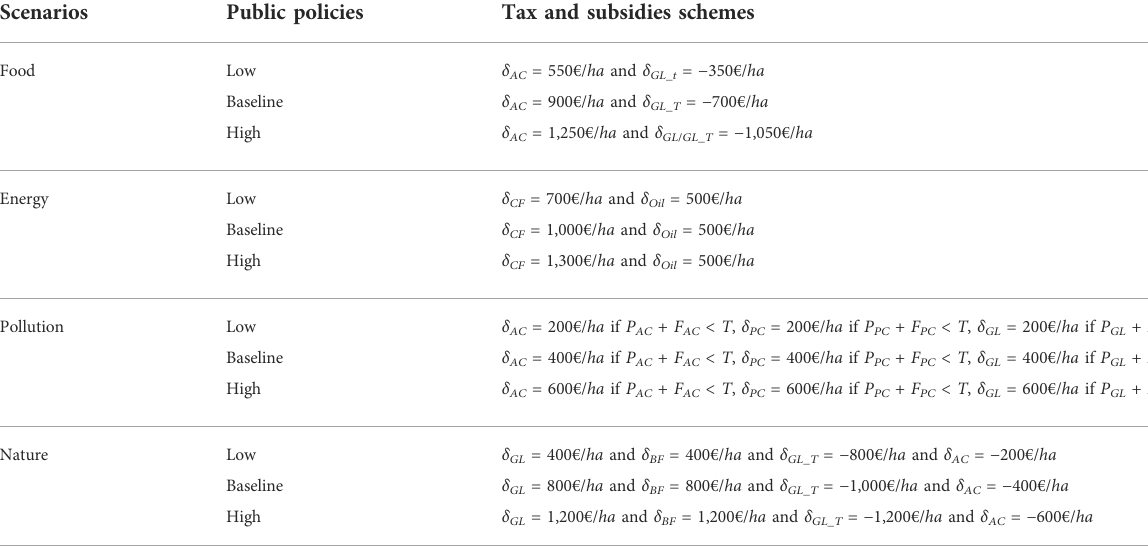
TABLE 2 Detailed description of public incentives for the 4 public policy scenarios: Food, Energy, Pollution and Nature. The baseline scenarios are supplemented with an upper and lower case (i.e. with higher and lower incentive levels than in the main case). Negative incentives are taxes and positive ones subsidies. Only subsidies of the Pollution scenario impose restriction on the use of phytosanitary products. P stand for pesticides, F for fertilizers, AC for annual cultures, Oil for oleaginous crops, GL T for temporary grasslands, GL for permanent grasslands, CF for coniferous forests, BL for broadleaves